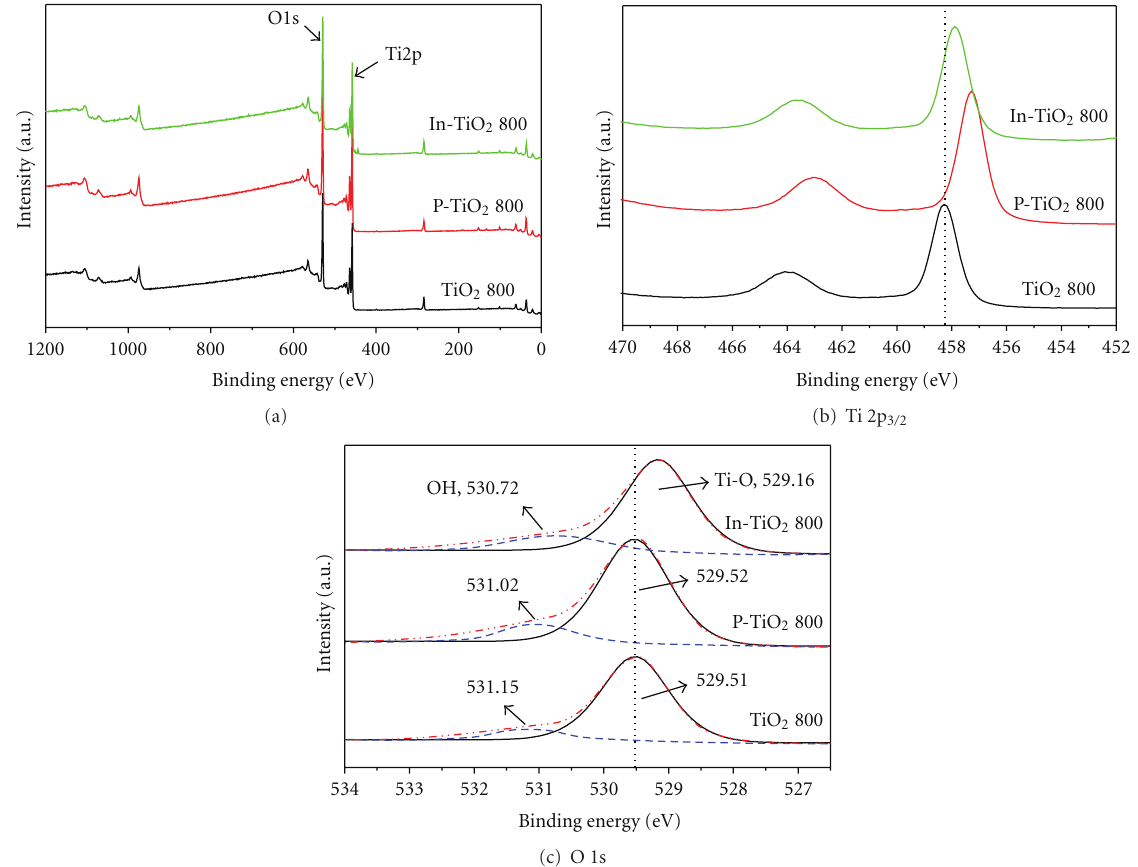
Figure 4: XPS analysis of (a) 1.0mol% In, P incorporated TiO 2 photocatalysts; (b) Ti 2p and (c) O 1s spin orbital.